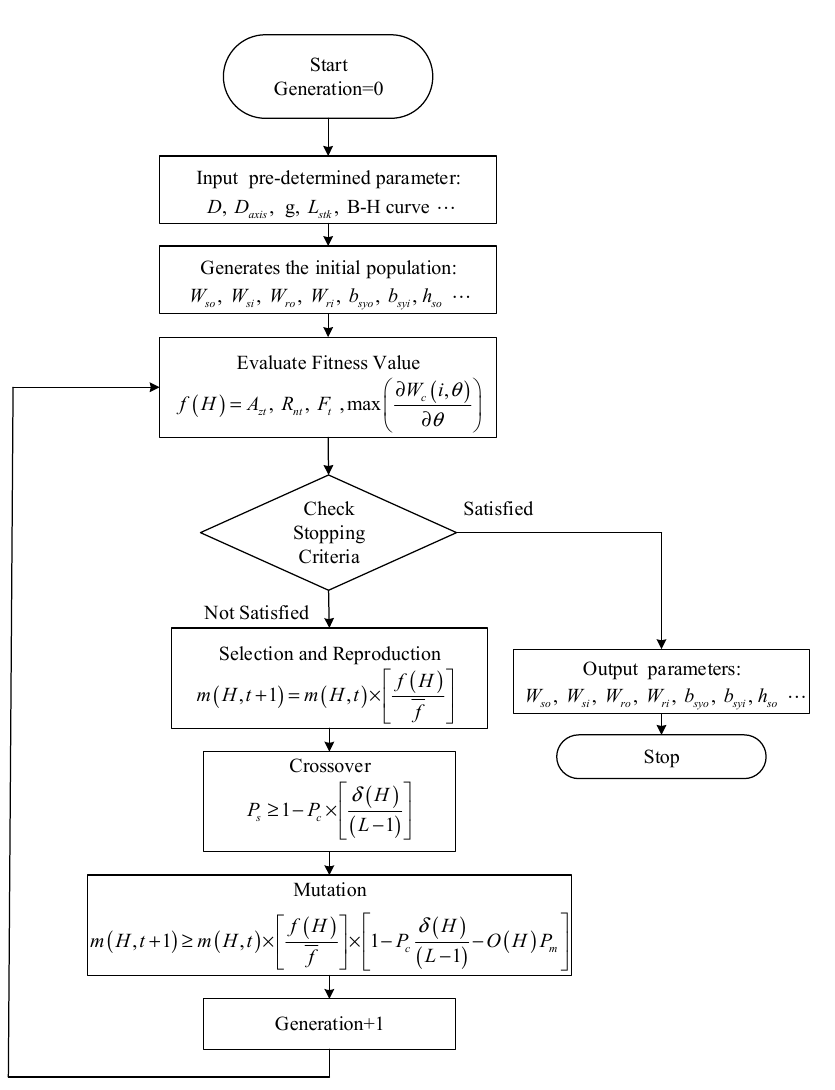
Figure 20. Operation procedures of Genetic algorithm for double-stators switched reluctance motor. Table 1. Optimal geometric parameters of the DSSRM (unit: mm).